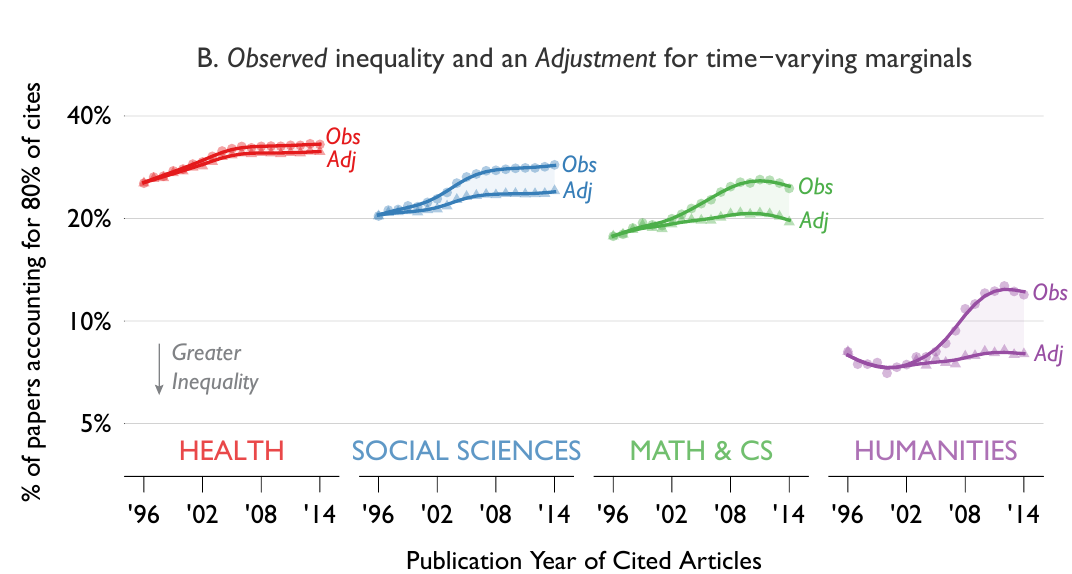
Figure 6: Percentage of articles accounting for 80 percent of all citations within two years of publication, 1996–2014: Monte Carlo simulation and empirical results. Notes : The lines in the top panel marked Sim show percentage of articles accounting for 80 percent of all citations from Monte Carlo results for hypothetical articles and citations designed to have a fixed pattern of inequality across years and fields, but total articles and citations matching the empirical marginals of those fields by year. The lines marked Cor remove the marginals bias using a resampling correction. The lines marked Obs in the bottom panel show the percentage of articles accounting for 80 percent of citations over fields and time using the empirical data from Web of Science; these results are subject to marginals bias from differences in total articles and citations by field and year. Lines marked Adj adjust for marginals bias in the empirical data by resampling to the marginals in 1996 by field. Corrections and adjustments are omitted for the humanities in 1997–2002. All curves are smoothing splines with a span of 0.5. One exceptionally highly cited article in mathematics and computer science is